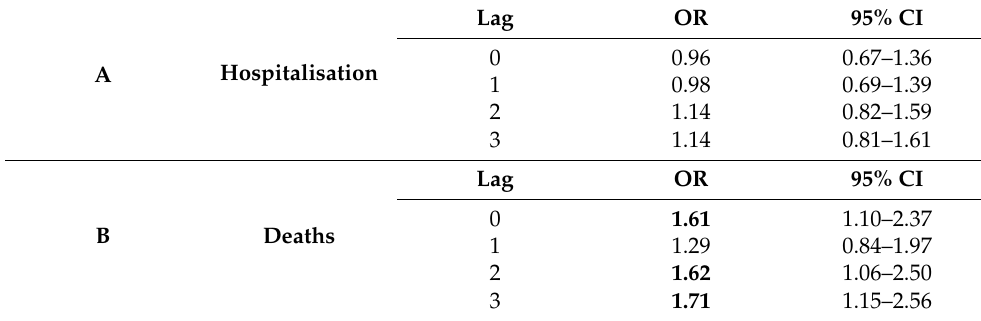
Table 3. Odds ratios (OR) at lag 0, 1, 2 and 3 days for hospitalisations (A) and deaths (B). 95% confidence interval (95% CI). Bold indicates the significant results at lag 0, 2, and